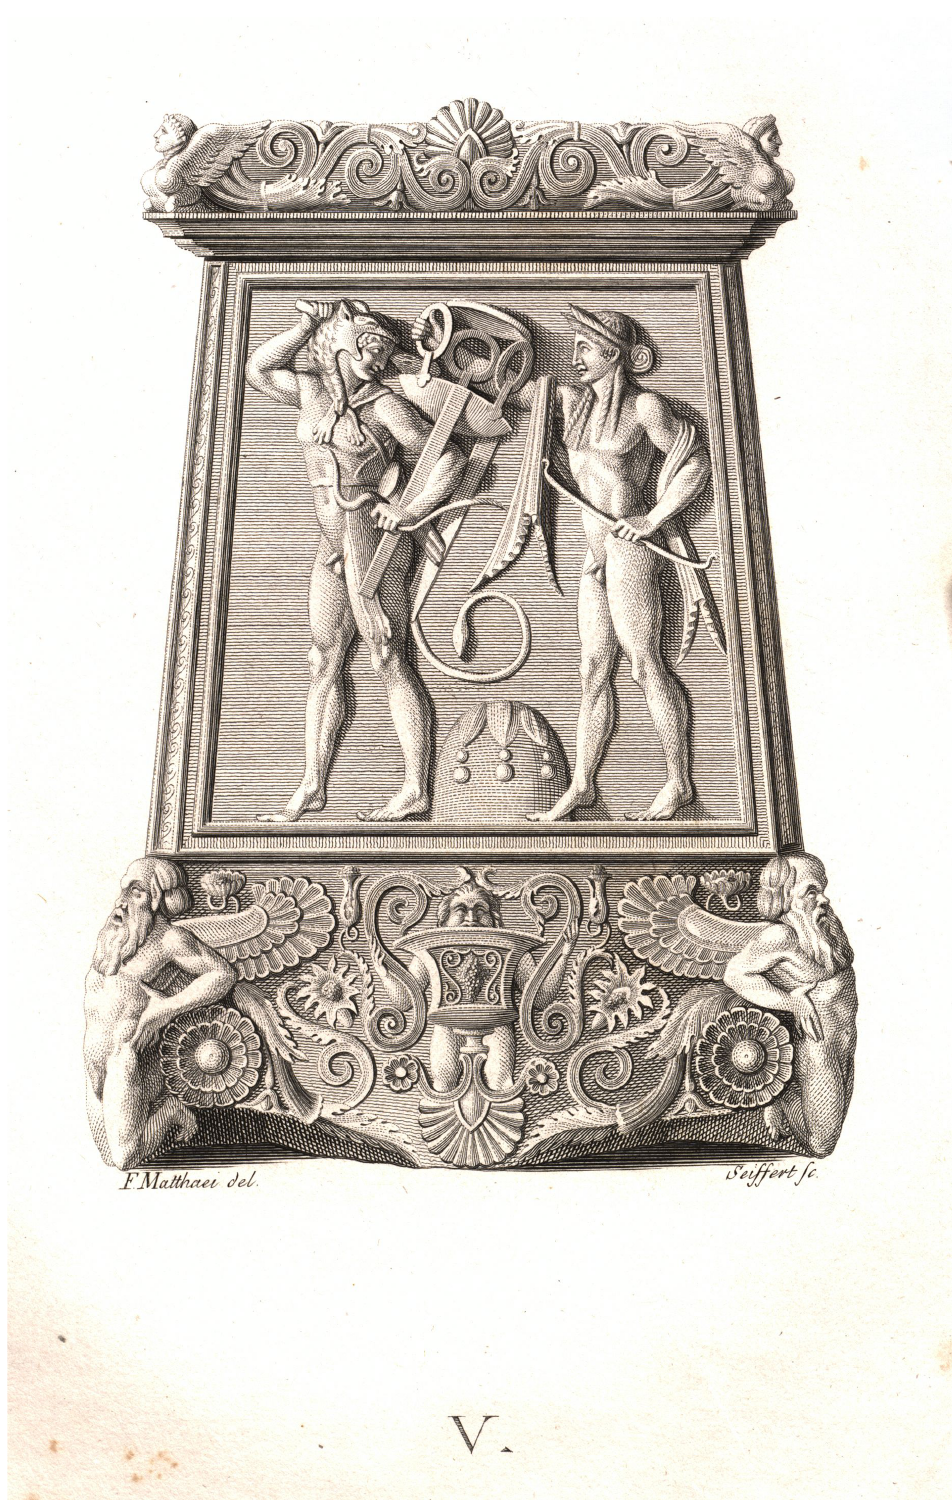
Figure 7 Candelabrum, in: Becker, Augusteum, plate V (photo: